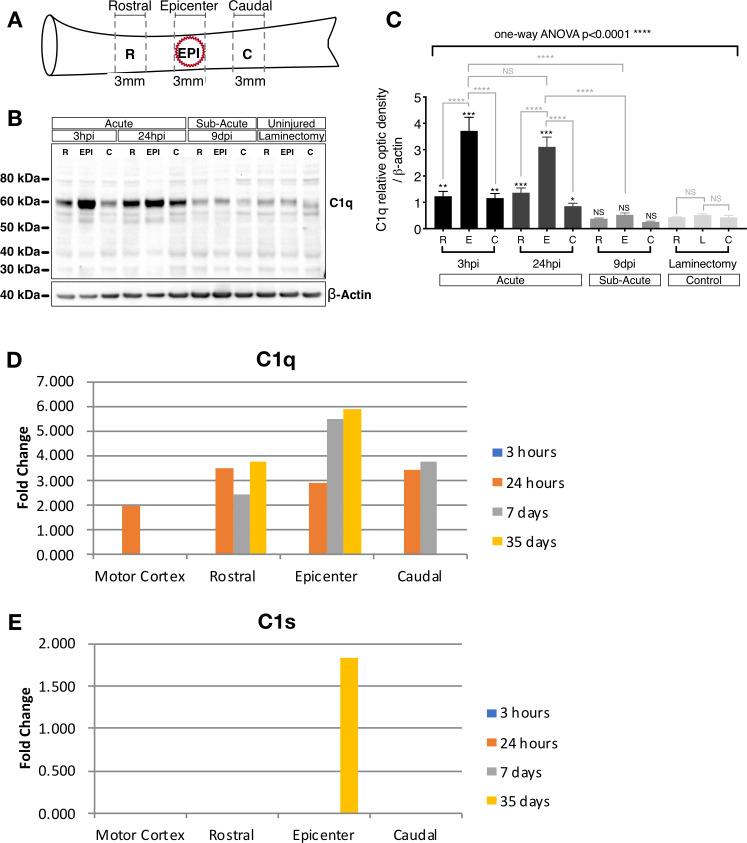
C1q protein increases in the epicenter acutely after SCI.(A) Schematic illustrating the spinal cord sections utilized to determine C1q protein levels following 50 KDa spinal cord contusion injury or laminectomy control. (B) C1q Western blot on 3 mm rostral, epicenter, and caudal sections after laminectomy or SCI at 3 hr, 24 hr, and 9 d post-SCI reveals significantly increased C1q protein levels in the epicenter and at acute (3 hr and 24 hr) time points. (C) C1q band intensities were normalized to β-actin. Data show mean ± SEM (N = 4 mice/time point) for quantified C1q optical intensities. Statistical analysis of C1q levels was significant using one-way ANOVA at ****p≤0.0001, followed by Tukey’s post-hoc t-test as indicated (NS, not significant; *p≤0.05, **p≤0.01, ***p≤0.001, ****p≤0.0001). (D,E) mRNA expression analysis reveals a parallel increase in local C1q mRNA synthesis at the injury epicenter that is not accompanied by C1s mRNA. (D) C1q and (E) C1s gene expression changes after spinal cord injury were obtained by data analysis of our published microarray data following contusive injury of the adult rat spinal cord. Differential gene expression was examined spatially, using tissue samples from the epicenter of the injury as well as 1 cm rostral and 1 cm caudal to the epicenter, and temporally, at 3 hr, 24 hr, 7 d, and 35 d post-injury, as described in Aimone et al., 2004.